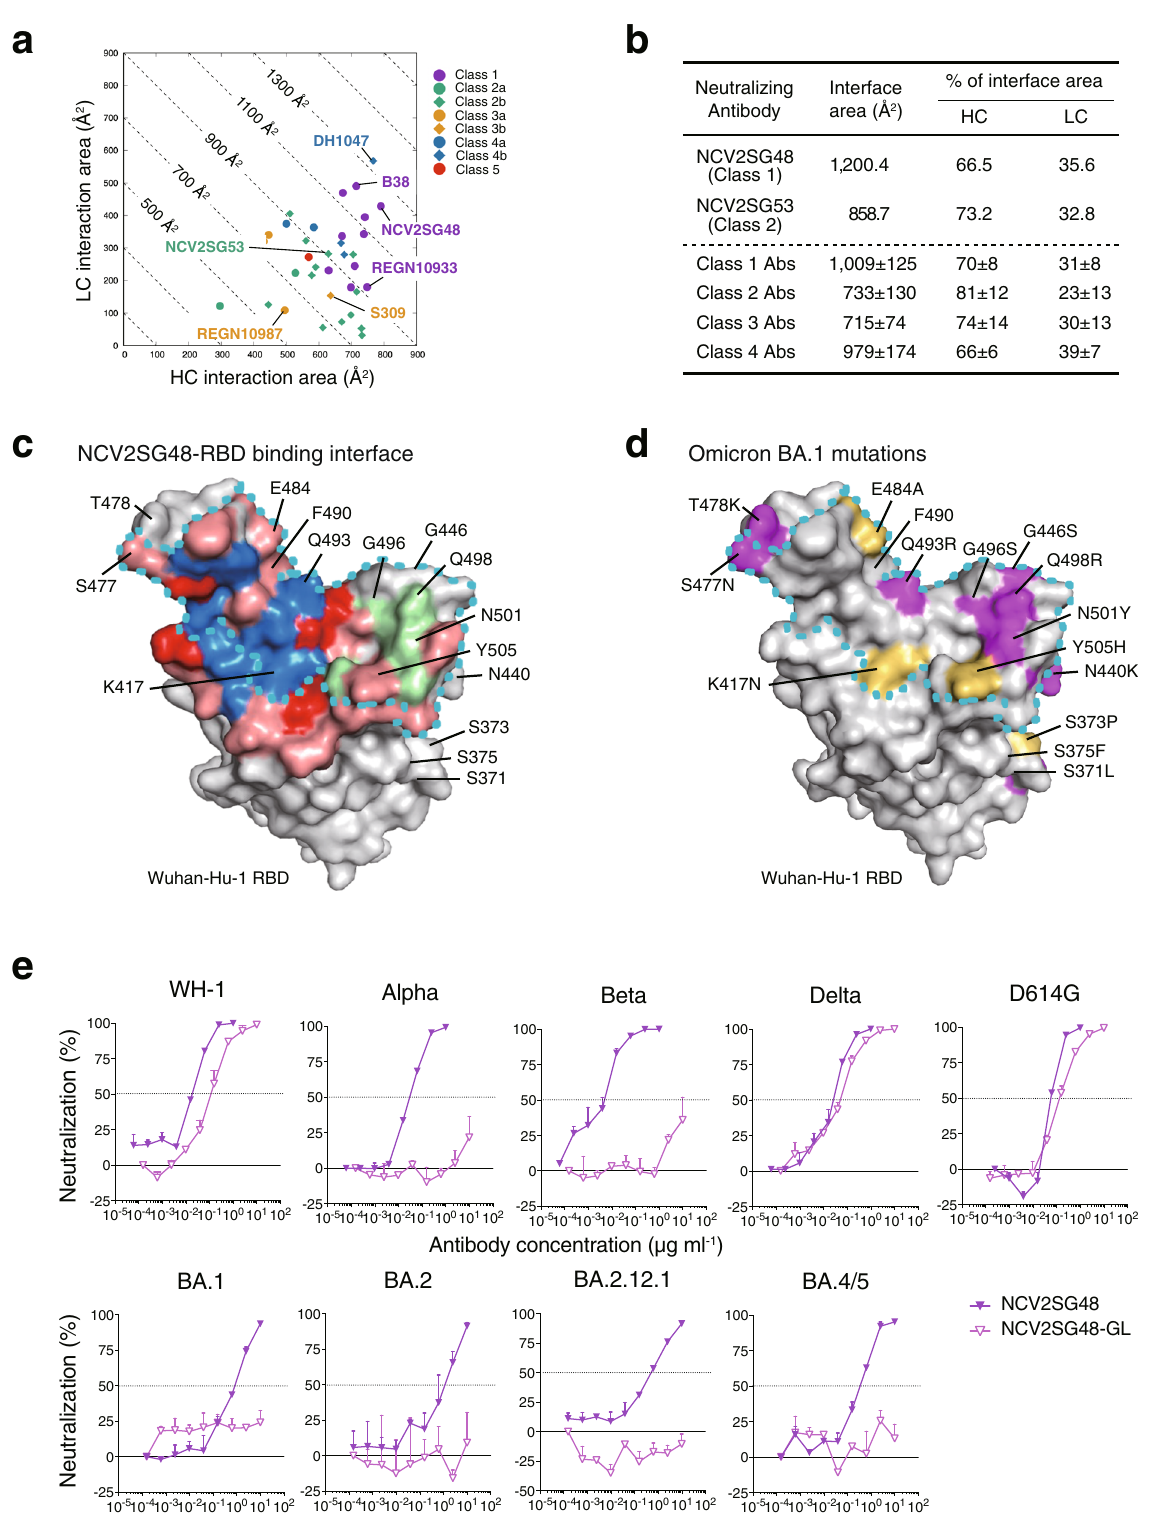
of the binding interface and increased binding af fi nity to RBD (Fig. 6b and Supplementary Fig. 5c). T57S mutation in HC-CDR2 could contribute to reducing the steric hindrance with F490 of RBD and increasing af fi nity around E484 (Fig. 6a, b). This explained well why the E484 mutation emerged in Beta and Omicron abolished neutralization by NCV2SG53 (Fig. 2).